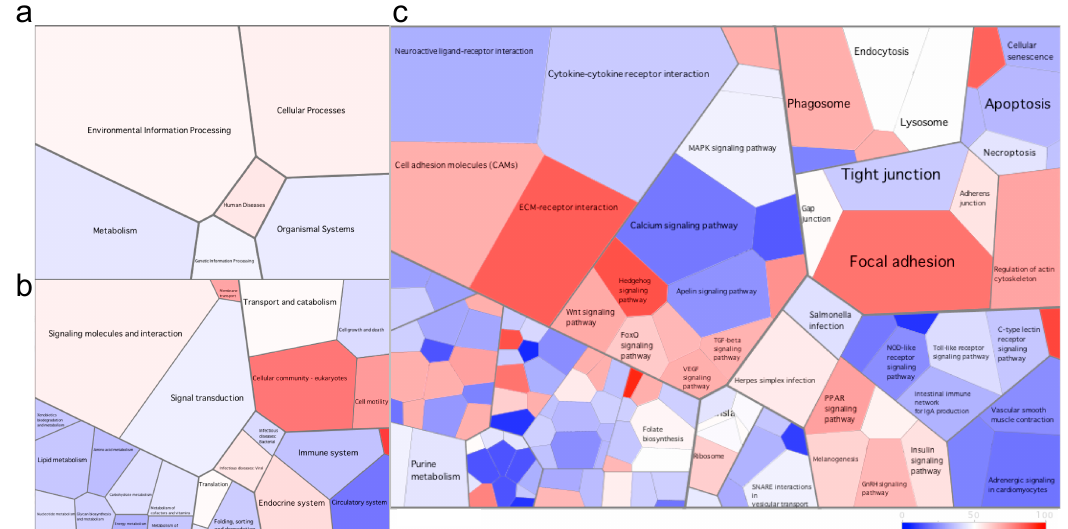
Figure 3. Voronoi tessellation diagrams representing differentially expressed pathways at ( a ) level 1, ( b ) level 2 and ( c ) level 3 of the KEGG database in the skin of the fish at the late stage of the disease. Each polygon represents an ontology term, with their size corresponding to the numbers of genes involved in the associated pathway. To further explore the pathways differentially expressed between health states, we imported all DEGs (and associated logs values) to generate the Voronoi tessellations. Pathways colored in red are upregulated, and those in blue are downregulated in the fish at the late stage of the disease when compared to healthy fish. A quantile color scale was used to show differential expression.